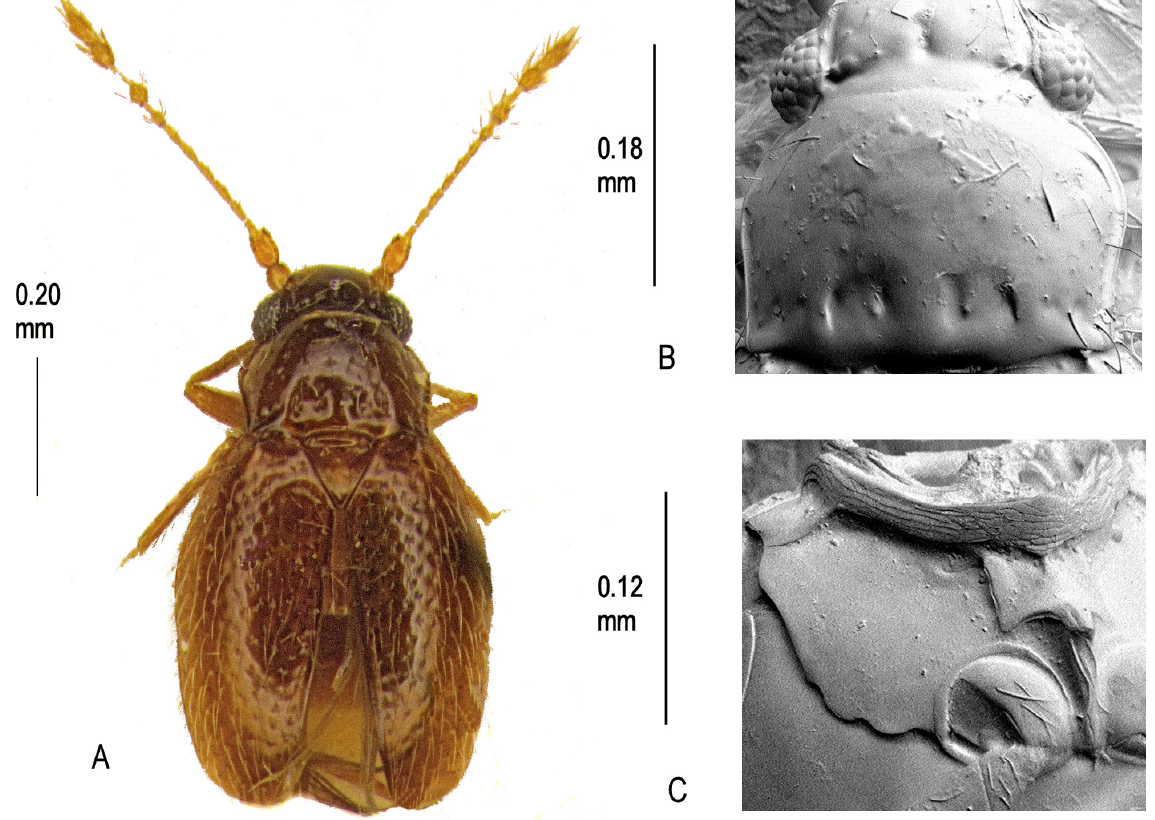
Fig. 24 . Cissidium foveolatum Johnson, 1982. A . Habitus. B . Pronotum, × 715. C . Mesoventrite showing median process of collar, mid-keel and keel,